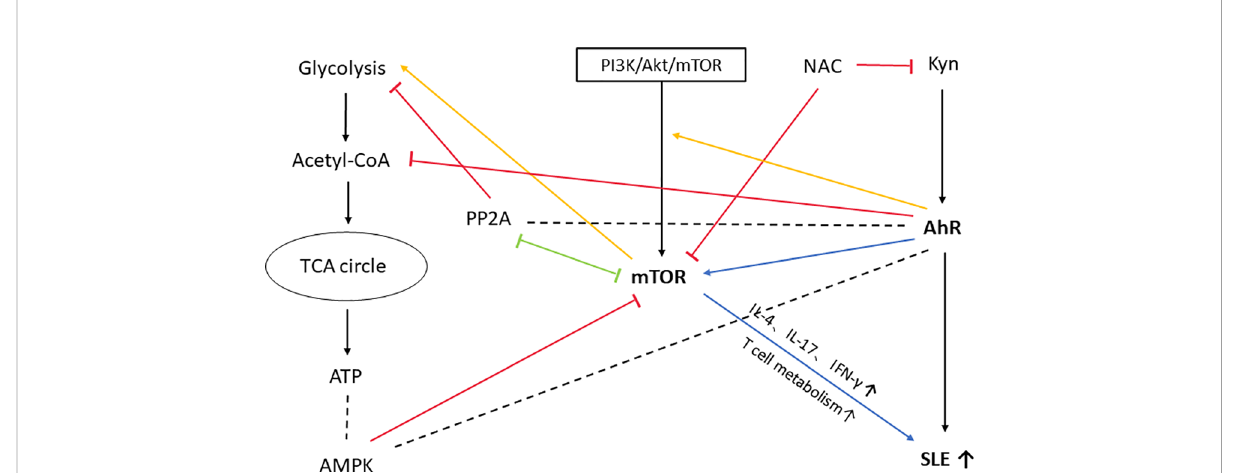
FIGURE 4 mTOR, an important moleculeinvolved in the development ofSLE by AhR. In this fi gure, weonly show the possibleassociation between the mTOR and AhR pathways and their effects onSLE.AhR can reduce acetylcoenzymeA levels and thus have an effectonmTORC1-induced glycolysis. mTORC1-induced glycolysis is also inhibited by PP2A, whichhas a negative crosstalk withmTORC1 and is a regulator of AhR. AMP-activated protein kinase (AMPK) is regulated by ATP/ADP or AMP/ATP ratio in the cell. Activated AMPK inhibits the activity ofmTORC1 (179).AMPK is also regulated by AhR-driven degradation ofSynphilin-1, whichcan reduce AMPK production (180).So PP2A andAMPK may be important molecules linking mTORto AhR. PI3K/Akt/mTORpathway is one ofthe upstream pathways regulating mTOR, andAhR enhances the activationof PI3K/Akt/mTOR